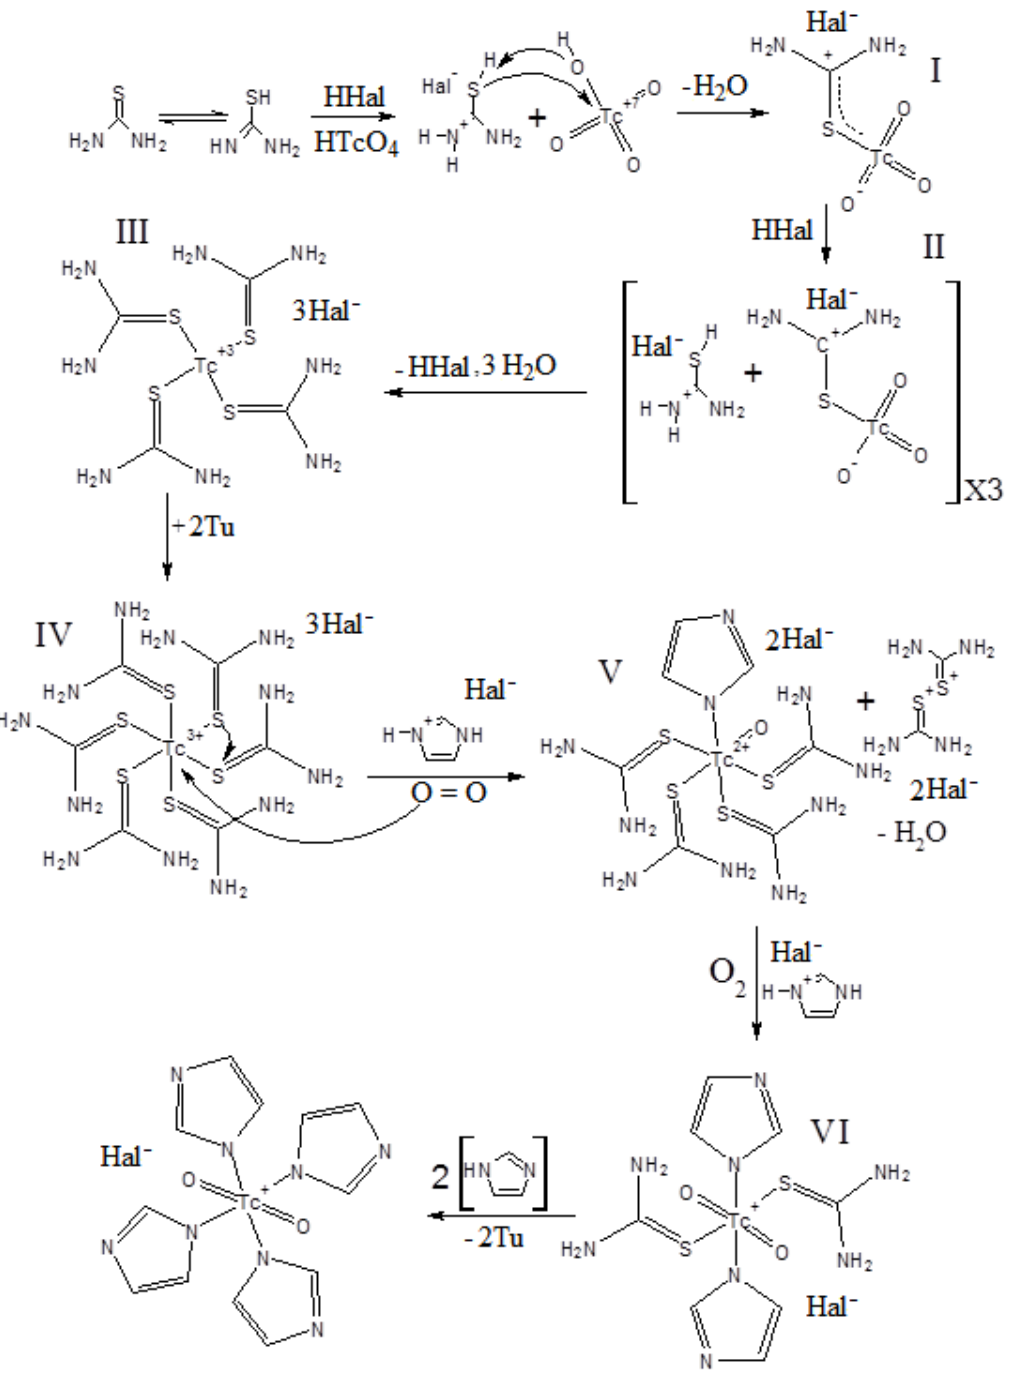
Figure 12. Proposed mechanism of Tc(VII) reduction in the presence of competitive ligands by thiourea with the formation of intermediate products.